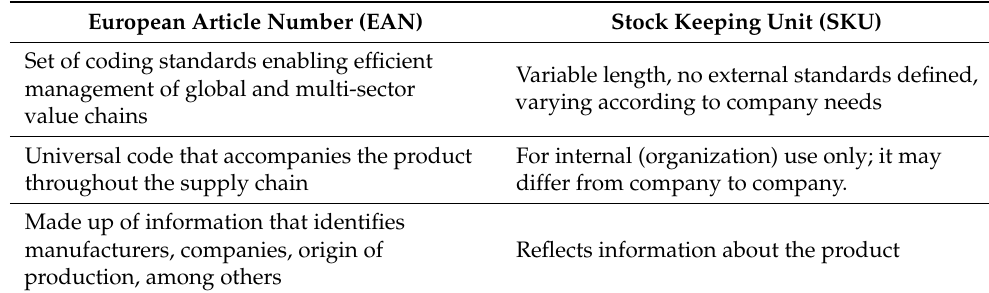
Table 1. Differences between the main barcode